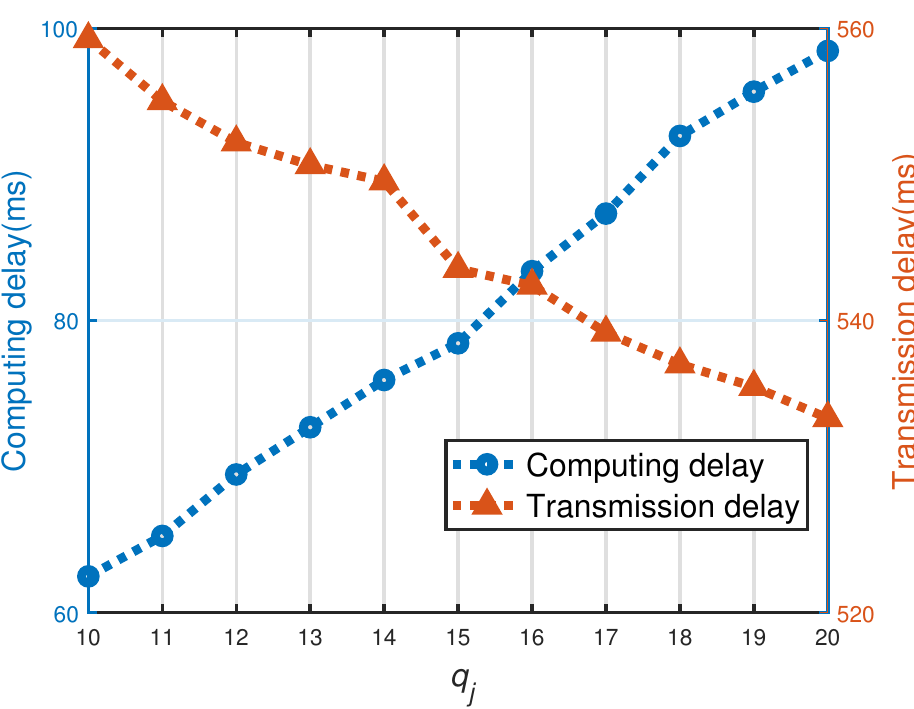
Figure 4. Computing delay and transmission delay versus q j .